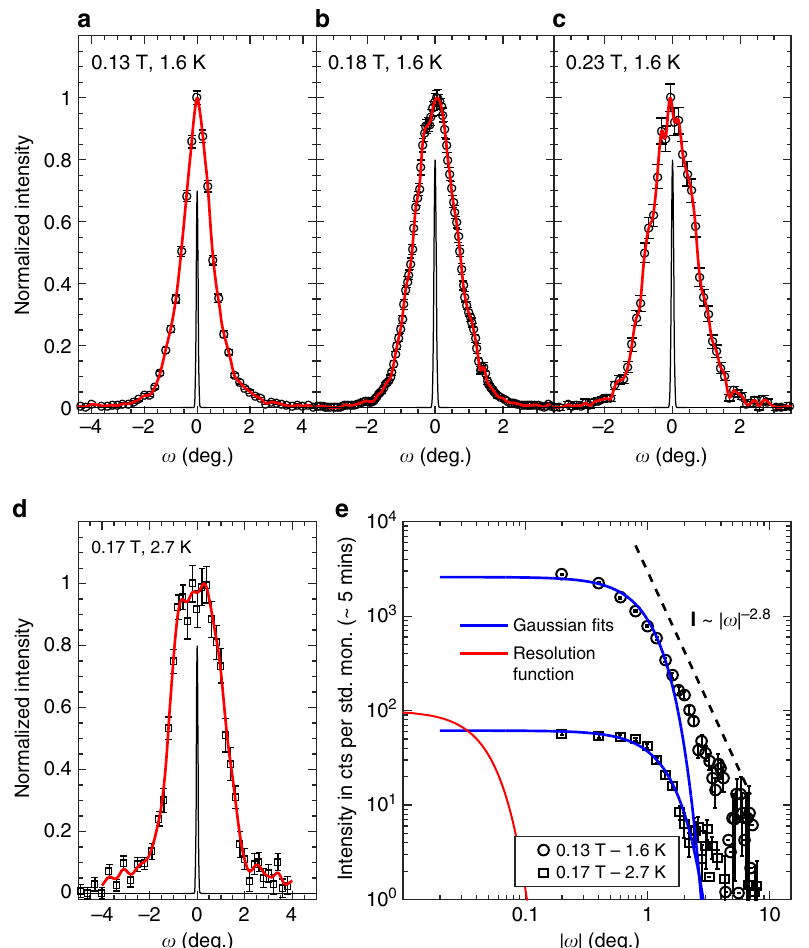
Fig. 7 Neutron scattering in perpendicular fi eld geometry. In the perpendicular fi eld geometry (Fig. 2b), rocking curves probe correlations in the plane of the vortices. a – d Rocking curves of the fi rst order diffraction peak at four selected points in the phase diagram, collected with long counting times to afford high quality data for reverse Monte Carlo re fi nement. Backgrounds measured at zero fi eld have been subtracted. Ordinate axes are normalised for comparison. In reverse Monte Carlo re fi nement, simulated vortices are displaced using a Monte Carlo method until the experimental rocking curve (circles) is reproduced (red lines). Black lines indicate instrument resolution. e Rocking curves of a and d on logarithmic axes. Dashed line is a guide showing an algebraic decay. Algebraic tails are expected from the Bragg glass picture. Gaussian fi ts (blue lines) are drawn for